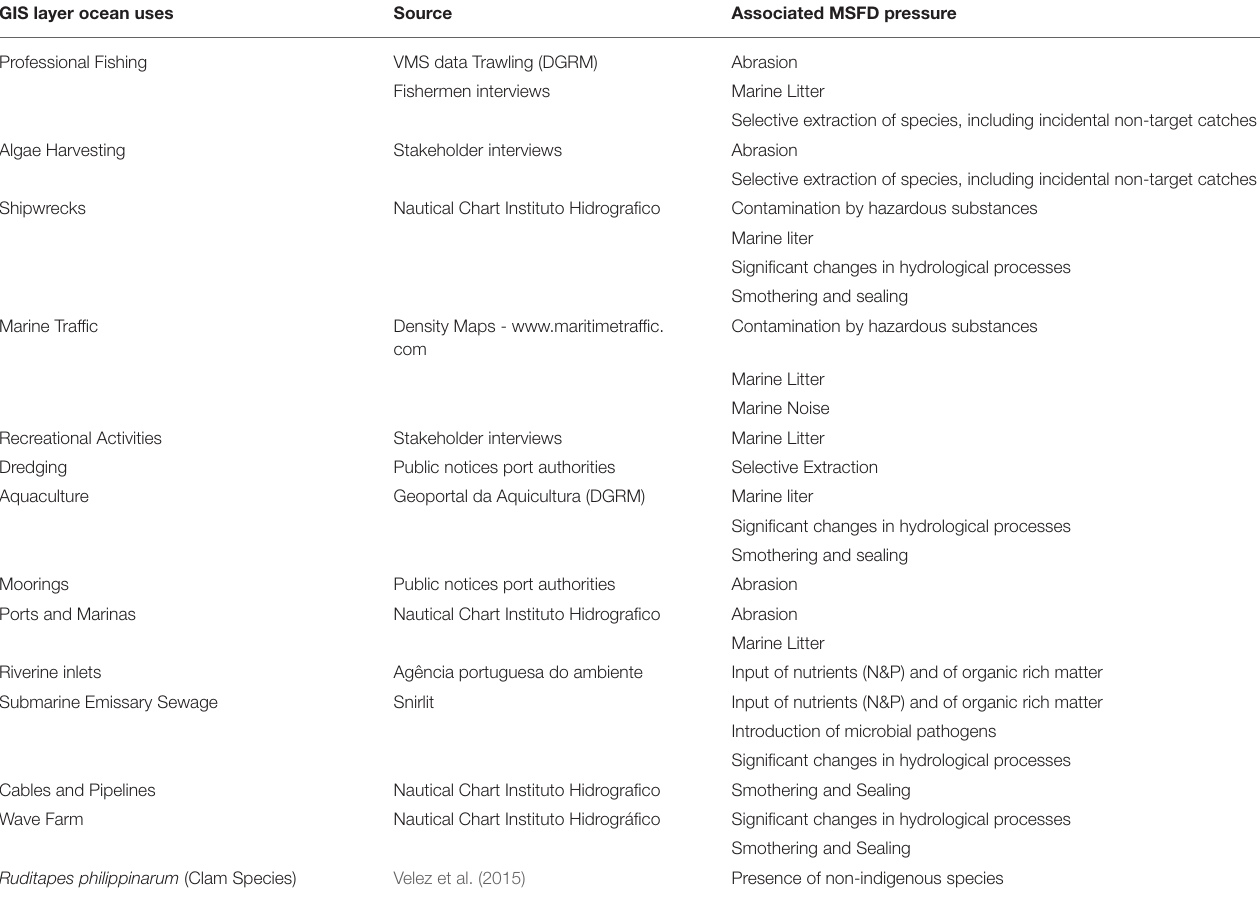
TABLE 1 | The constructed GIS layers and associated pressures following the Maritime Spatial Framework Directive (MSFD;